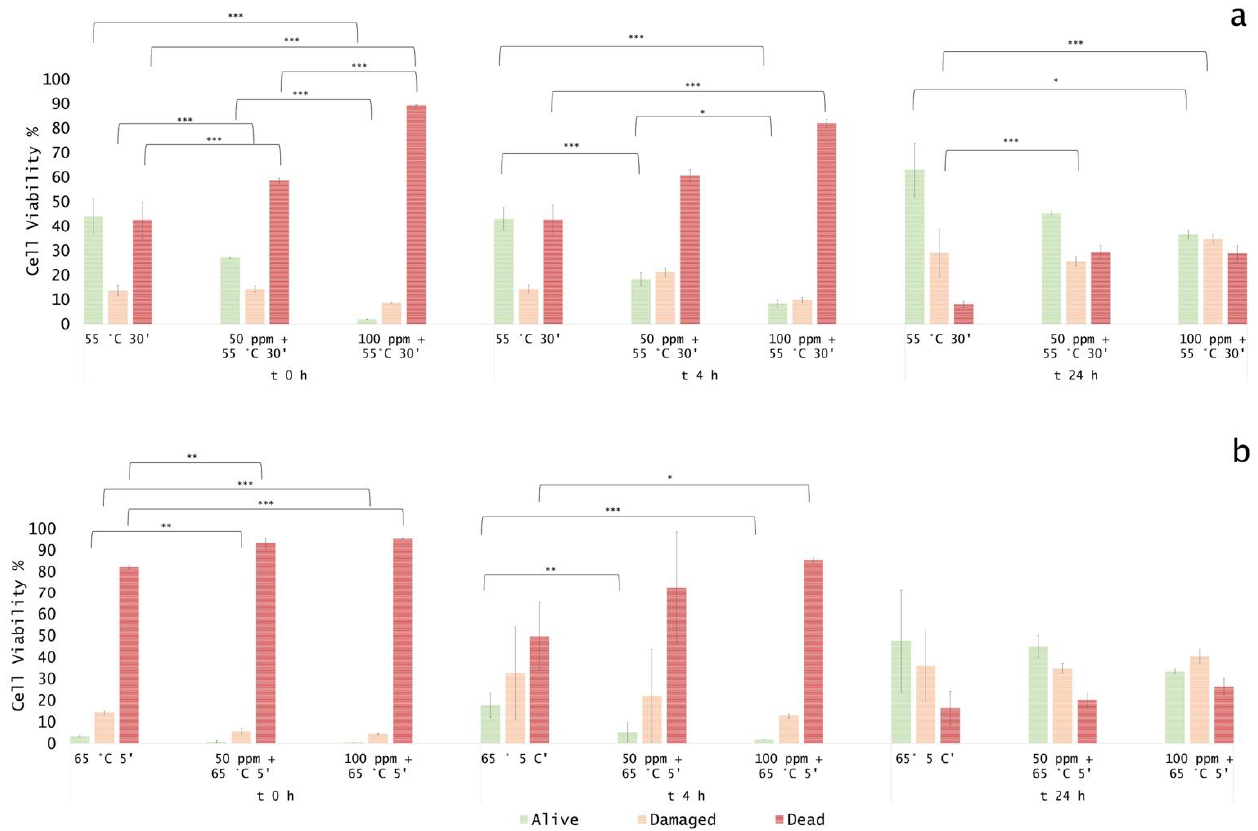
Figure 7. Percentage of alive, dead, and damaged cells calculated on total FCM events (100%): ( a ) combined thermal treatment at 55 °C 30 min and ( b ) 65 °C with or without OEO at 0, 4, and 24 h of incubation, compared to thermal treatment alone. The shown values correspond to the means and standard deviations for replicates, independently analysed. P -value less than 0.05 is flagged with one star (*), less than 0.01 with 2 stars (**) and less than 0.001 with three stars (***).